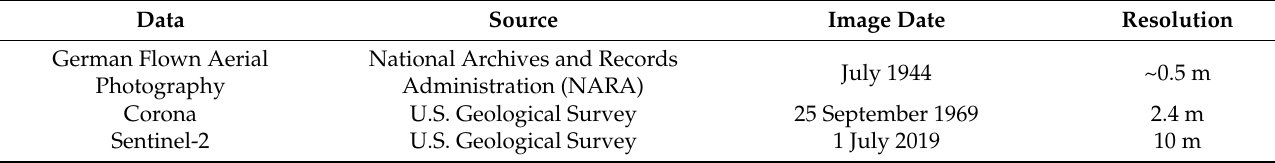
Table 1. Remote sensing data used in this